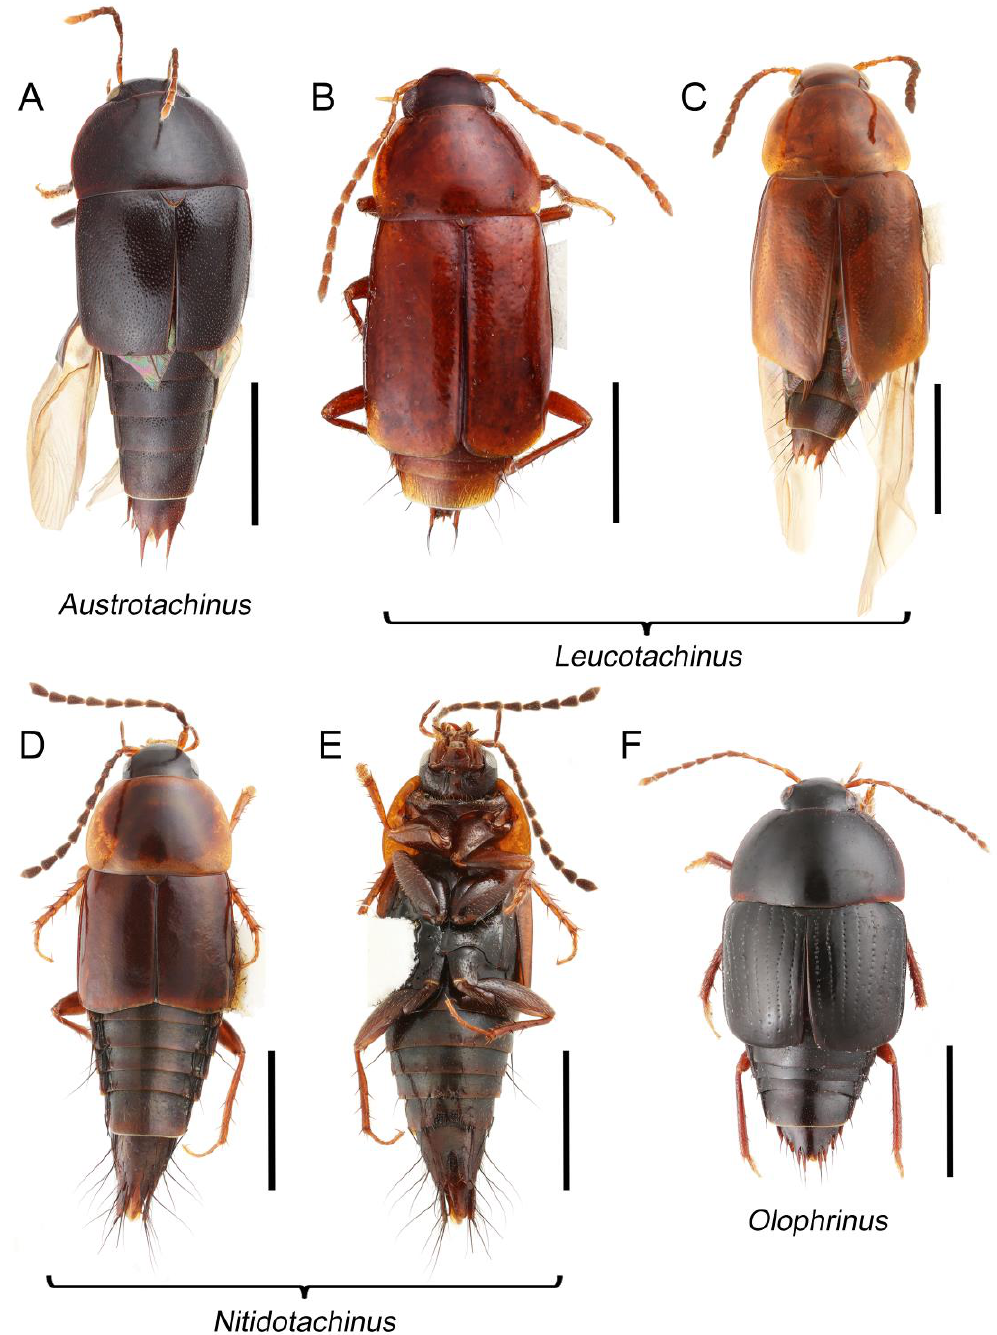
Figure 48. Habitus photographs of Tachinusini. ( A ) Austrotachinus fuscipes , dorsal view. ( B ) Leucotach- inus luteonitens (Fairmaire & Germain) from Chile, dorsal view. ( C ) Leucotachinus novitius (Blackburn) from Australia, dorsal view. ( D ) Nitidotachinus tachyporoides (Horn), dorsal view. ( E ) Nitidotachinus tachyporoides , ventral view. ( F ) Olophrinus cf. philippinus Campbell, dorsal view. Scale bars: 2.0 mm ( A , F ); 1.5 mm ( B – E